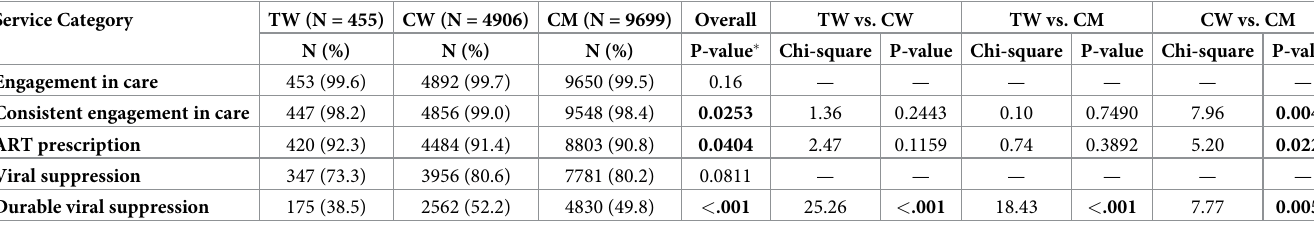
TW, transgender women; CW, cisgender women; CM, cisgender men; ART, antiretroviral therapy; HIV, human immunodeficiency virus.